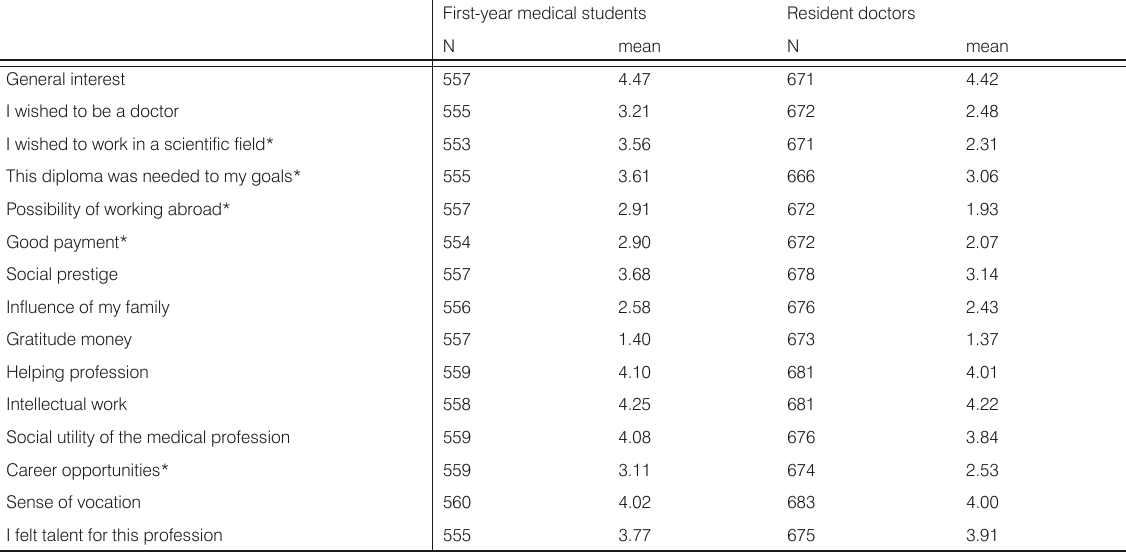
* significant difference according to the two sample t-test. p < 0.05 Table 2. Upon applying to medical training what was your aim after graduation?